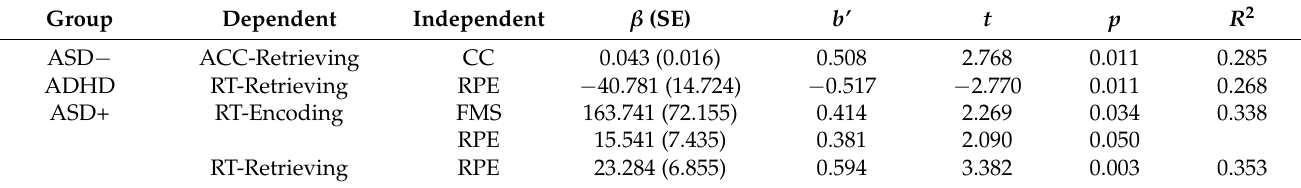
Table 5. Multiple regression analysis between EF and VSWM across